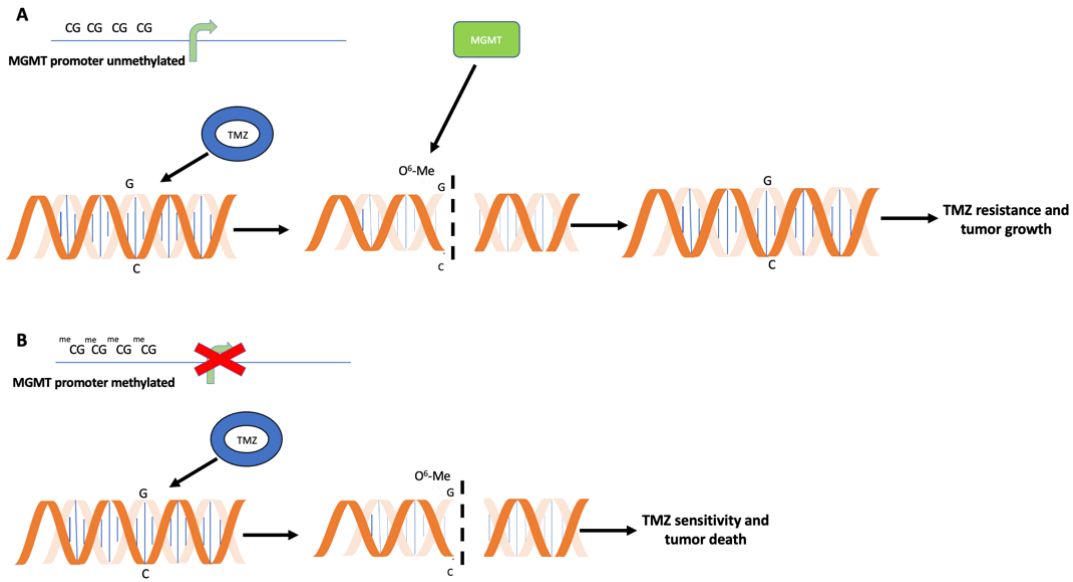
Figure 1. Antagonistic action between temozolomide (TMZ) and O 6 -Methylguanine-DNA Methyltransferase (MGMT) enzymatic activity. ( A ) TMZ drug (blue circle) modifies guanine (G) in O 6 -methylguanine (O 6 -MeG), creating mismatches in DNA sequence and, in turn, DNA breaks. Unmethylated MGMT promoter is associated with MGMT gene expression and MGMT protein synthesis (green rectangle). MGMT removes methyl-group on guanosine, re-establishing correct sequence. This event is associated with TMZ resistance, tumor growth and poor prognosis. ( B )